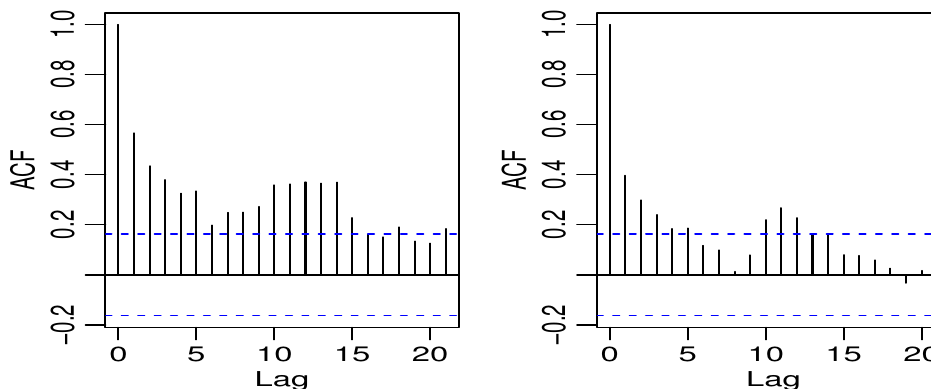
Figure 2. The ACF plot of CDRUGS and CSHOTS data.